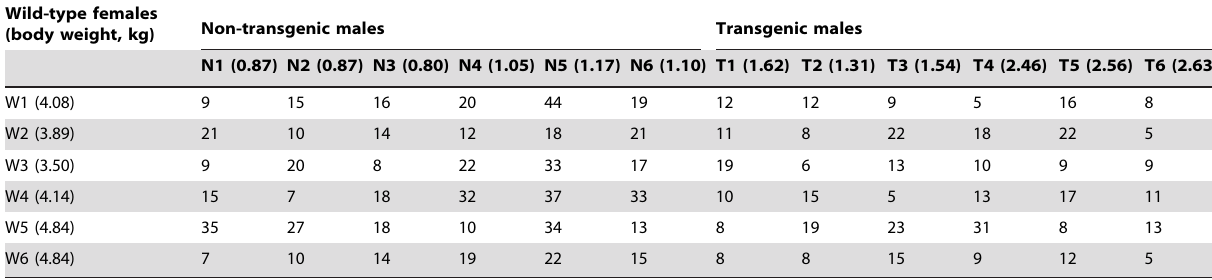
Wild-type females (body weight, kg) Non-transgenic